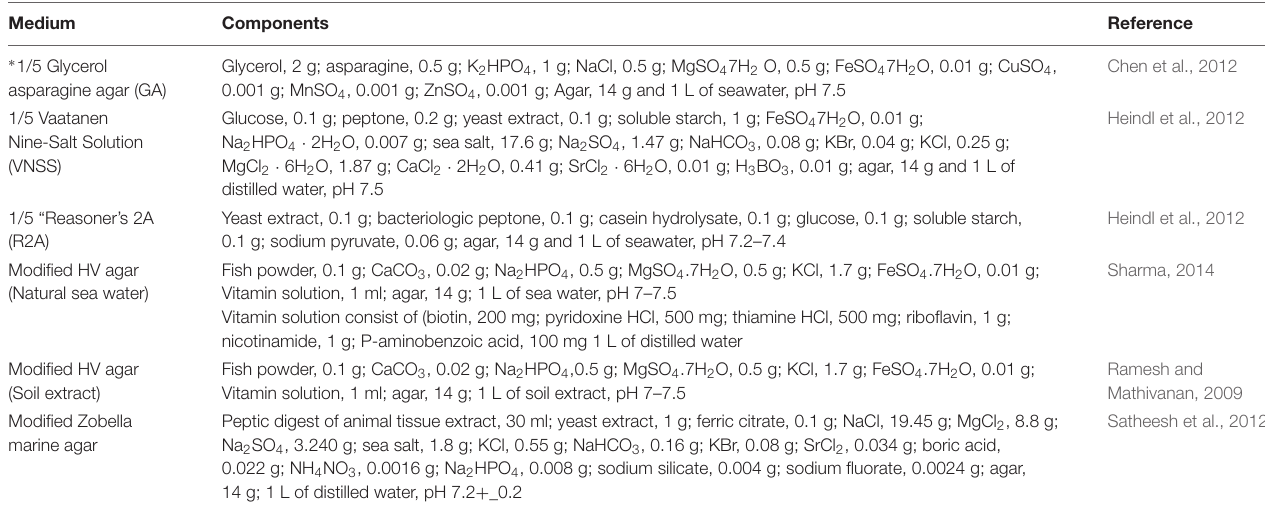
TABLE 1 | The modified media used in isolation of marine-derived Actinobacteria from sediment